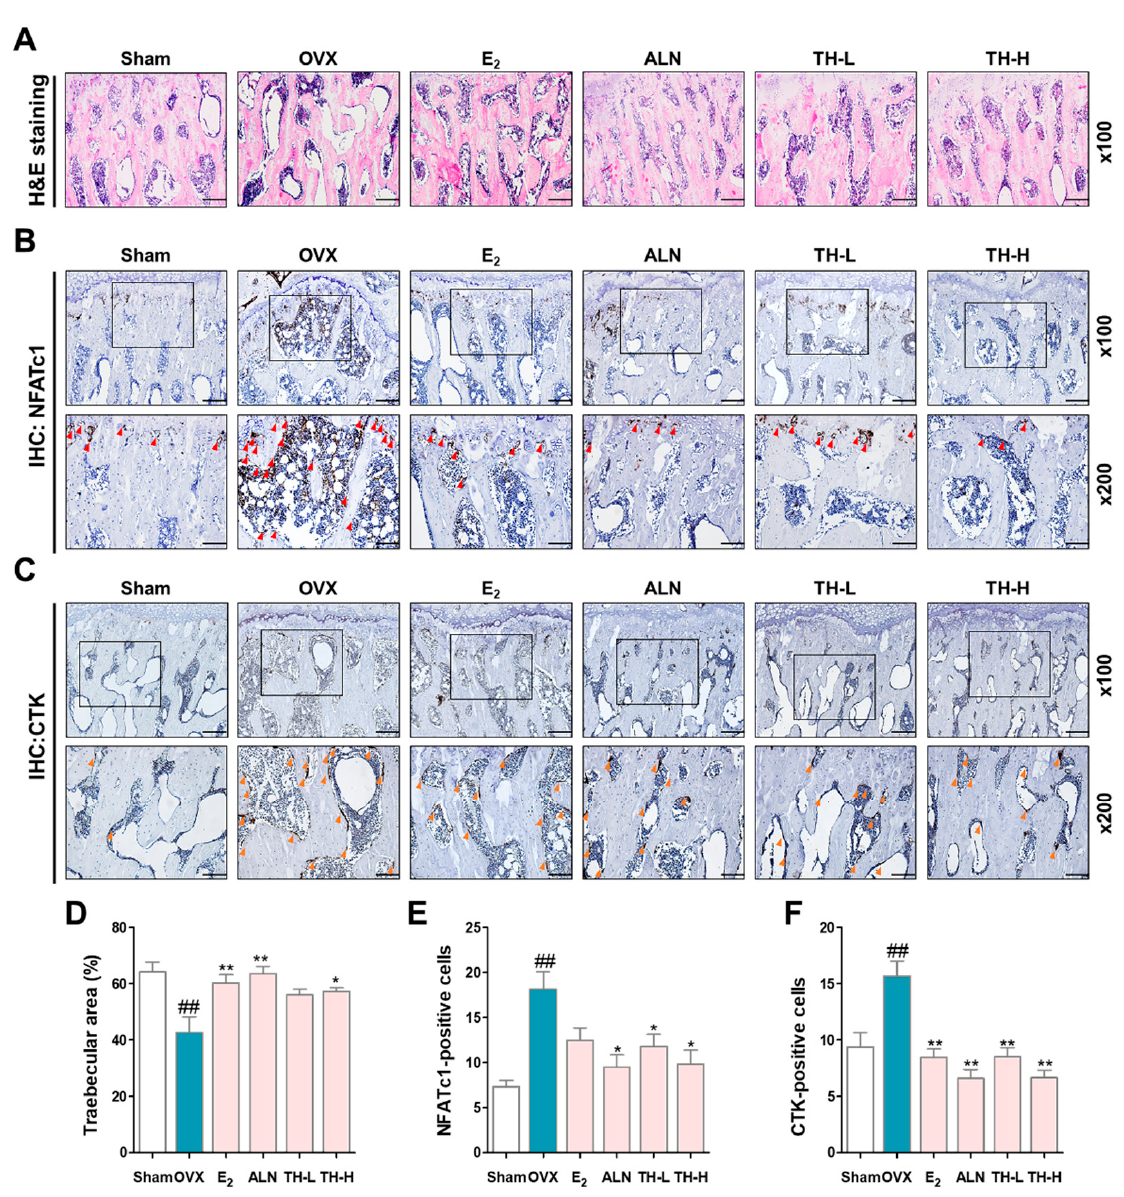
Figure 8. Taraxaci Herba (TH) treatment attenuated the trabecular area and expression of nuclear factor of activated T cells 1 (NFATc1) and cathepsin K (CTK) in bone tissue. ( A ) Representative hematoxylin and eosin (H&E) images of femur tissue. ( B , C ) Representative immunohistochemistry (IHC) staining images used to assess NFATc1 (red arrows) and CTK (orange arrows). ( D ) The trabecular area was measured using ImageJ software. ( E , F ) Quantification of NFATc1- and CTK-positive cells counted using ImageJ software Ver. 1.46. The experiments’ representative images are shown, and the graphs are expressed as the mean ± standard error of the mean (SEM; n = 8). ## p < 0.01 vs. sham group; * p < 0.05, ** p < 0.01 vs. OVX group.